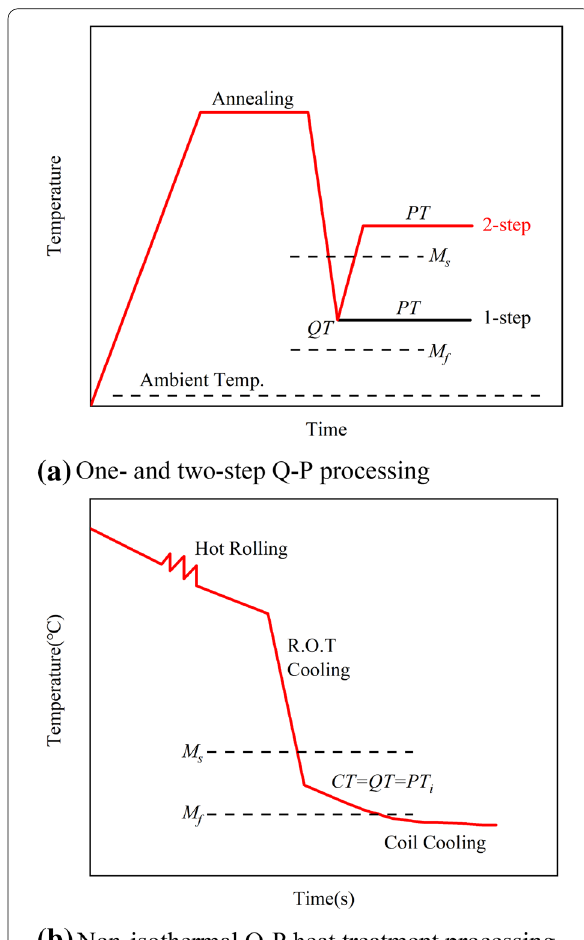
Figure 1 Schematics for conventional heat treatment